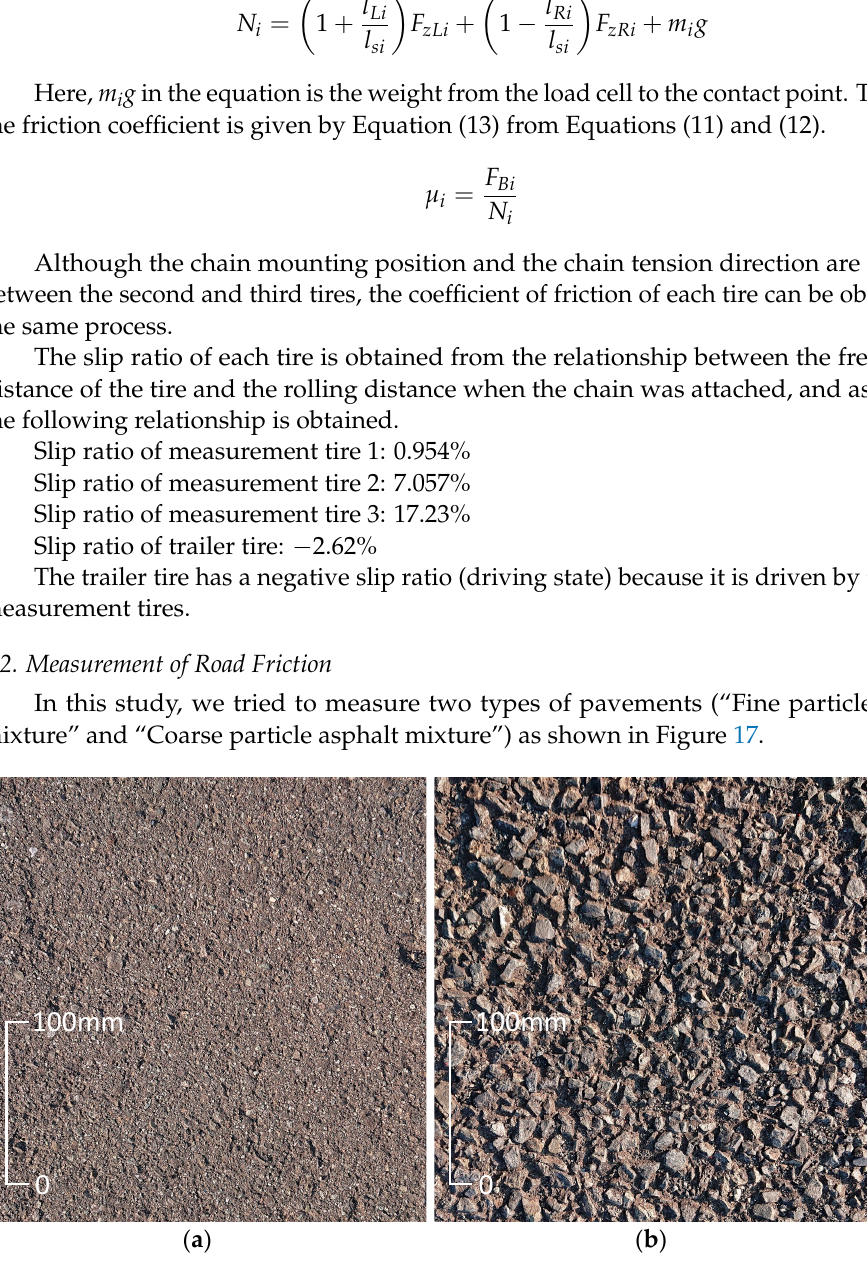
Figure 17. Pavement surface used for measurement. ( a ) Fine particle asphalt mixture (Asphalt pavement). ( b ) Coarse particle asphalt mixture (Permeable